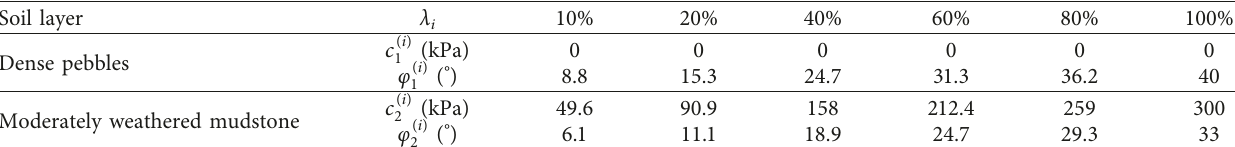
Figure 3: Soil reaction of the built-in section and lateral displacement of the supporting pile. Table 4: Strength parameters of the soil deformation state corresponding to different stress